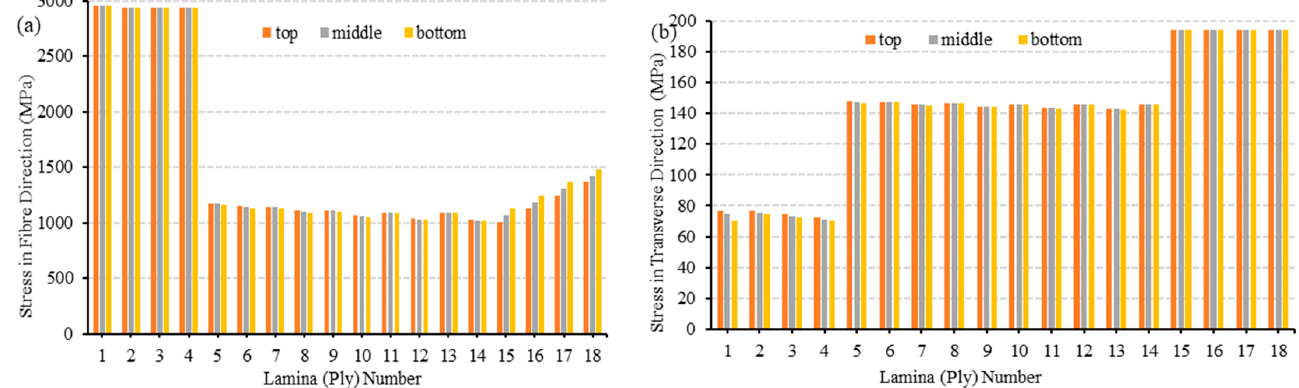
Table 8. Riser deformation and liner stress during burst event’s preliminary design.